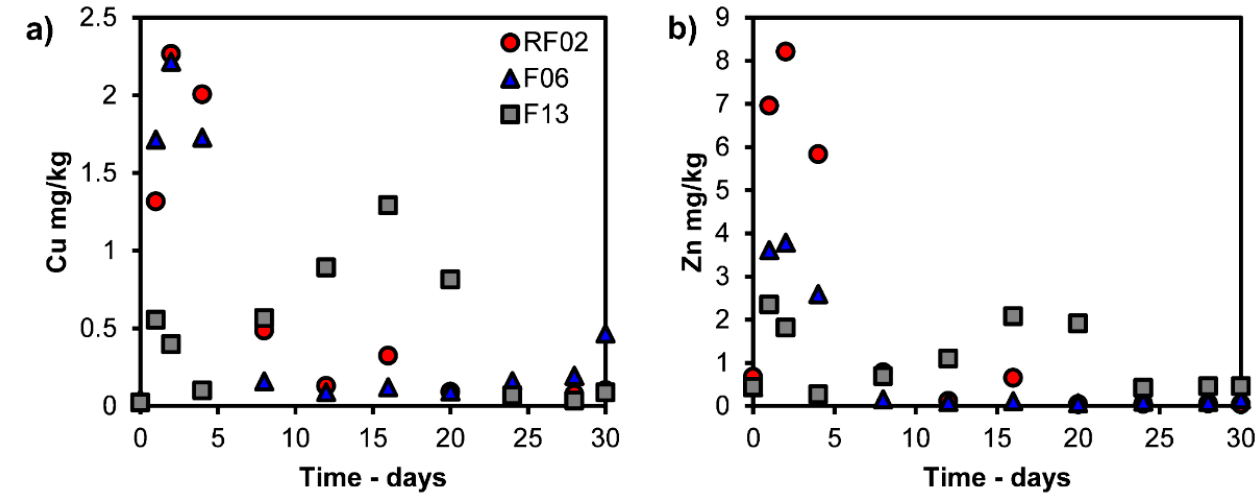
Figure 5. Leaching values of ( a ) Cu and ( b ) Zn (mg/kg) versus time from dynamic leaching tests.